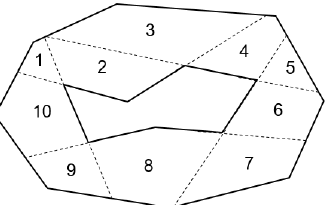
Figure 8. Initial sub-polygon set with